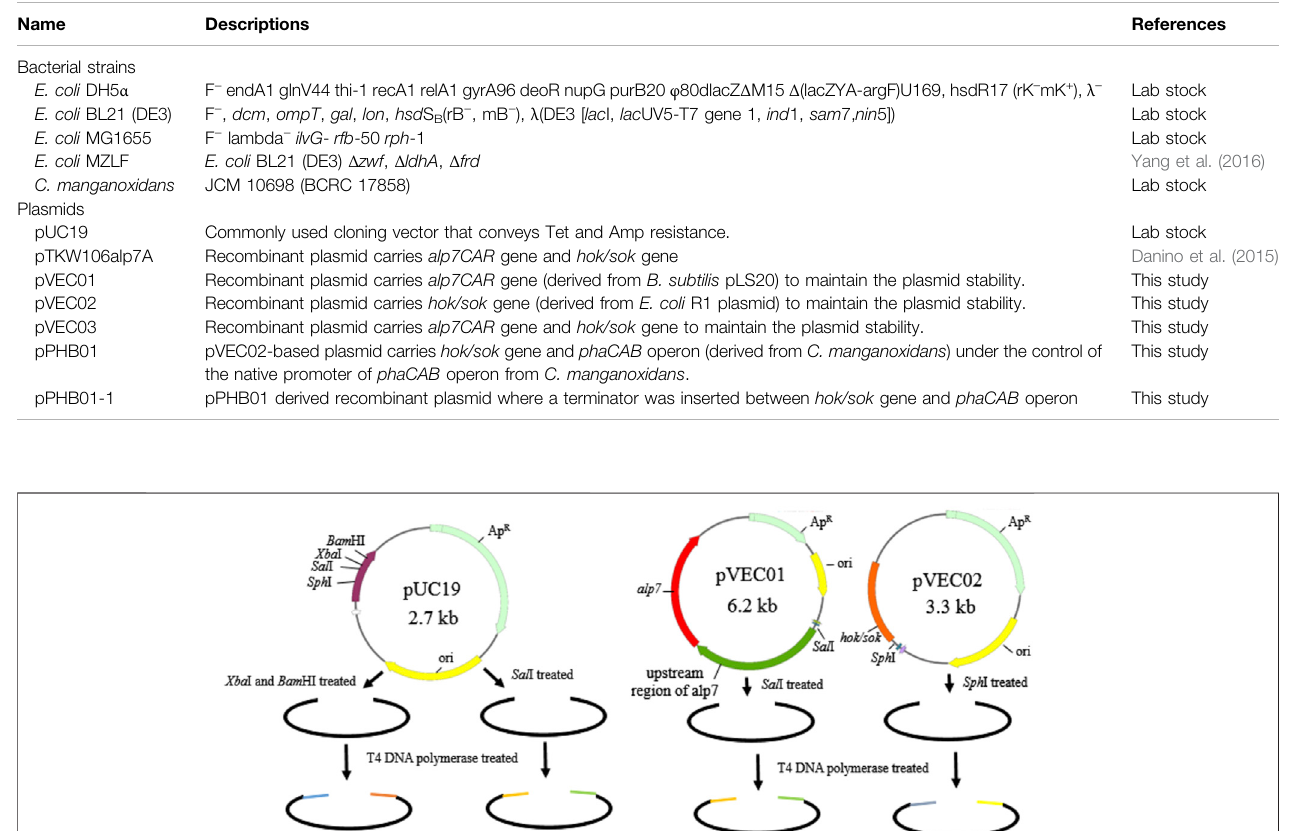
TABLE 1 | List of bacterial strains and plasmids used in this study.